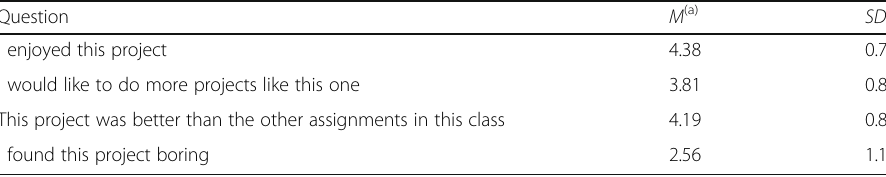
Table 3 Follow-up questionnaire motivation items ( n = 16)